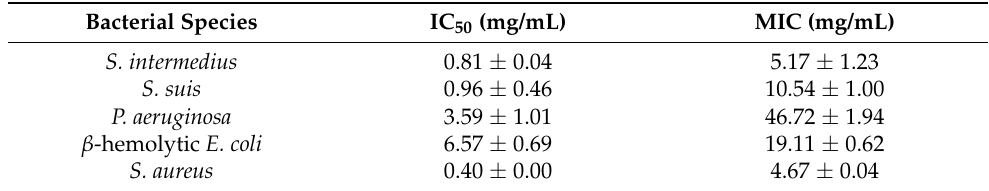
Table 4. Minimum Inhibitory Concentrations (MICs) and Half-Maximal Inhibitory